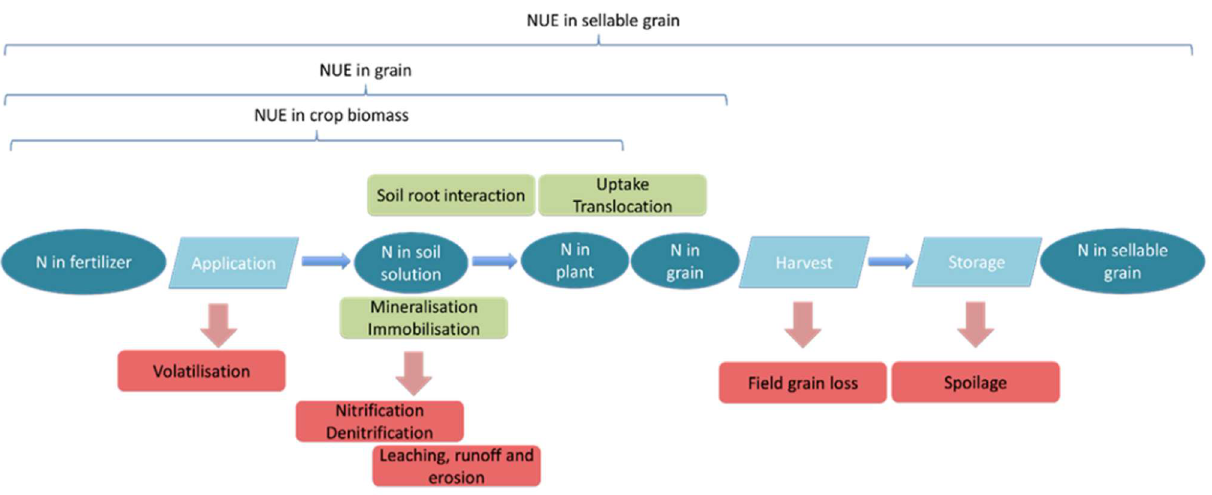
Figure 3. N flow through the soil plant system. Note: Soil pools are oval, and mechanisms are rec- tangular. Red rectangles indicate losses; green rectangles indicate transformation .